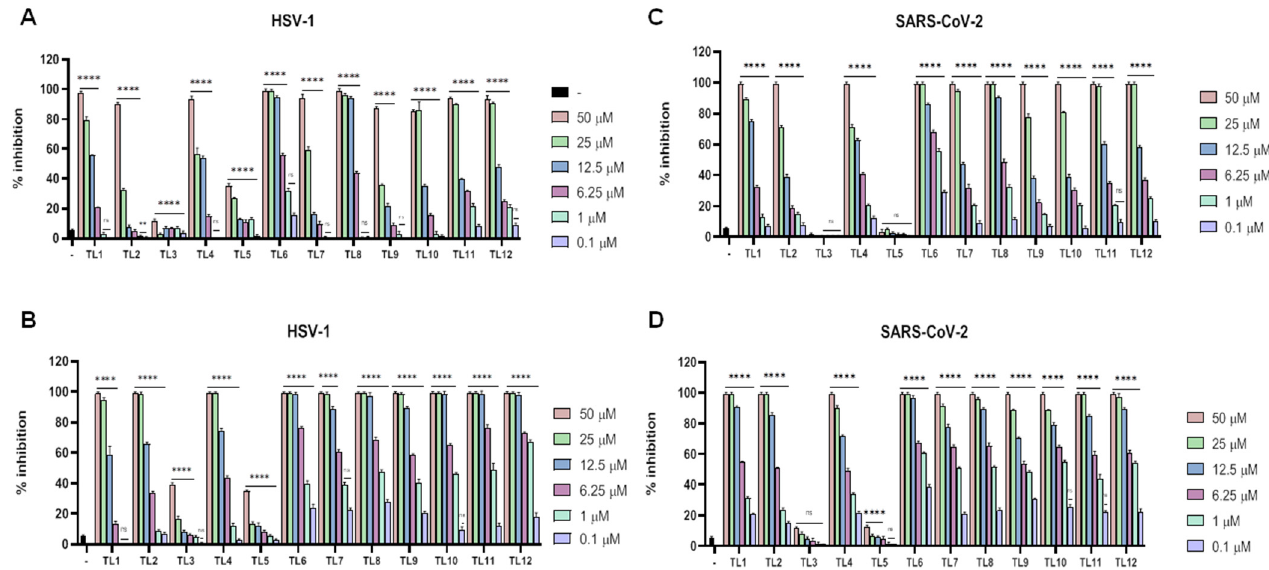
Figure 4. Antiviral activity of TL1 analogues against enveloped DNA and RNA viruses. ( A , C ) Co- treatment assay against HSV-1 and SARS-CoV-2 respectively; ( B , D ) virus pretreatment assay against HSV-1 and SARS-CoV-2 respectively. **** p < 0.0001; *** p < 0.001; ** p < 0.01; * p < 0.1; ns: nonsignificant. – indicates the infected and not treated cells.